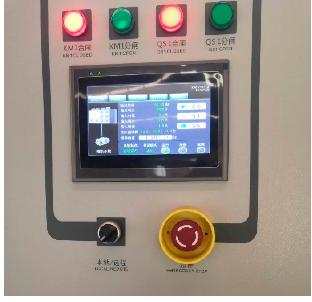
Figure 25. HVLSPMSM console.